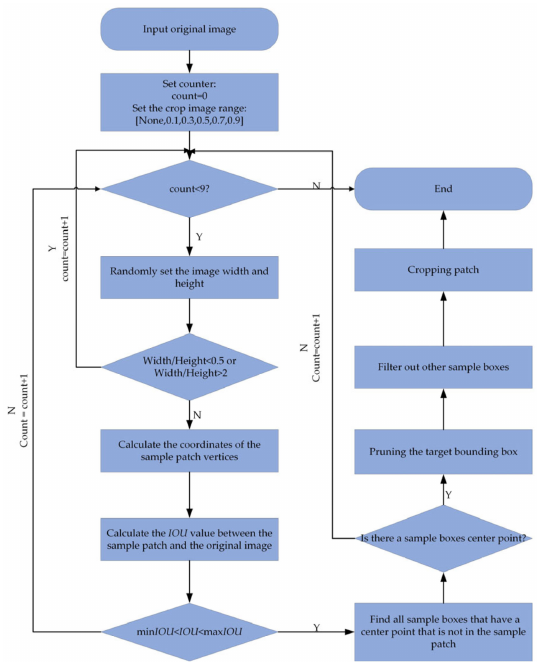
Figure 8. Flow chart of random cropping